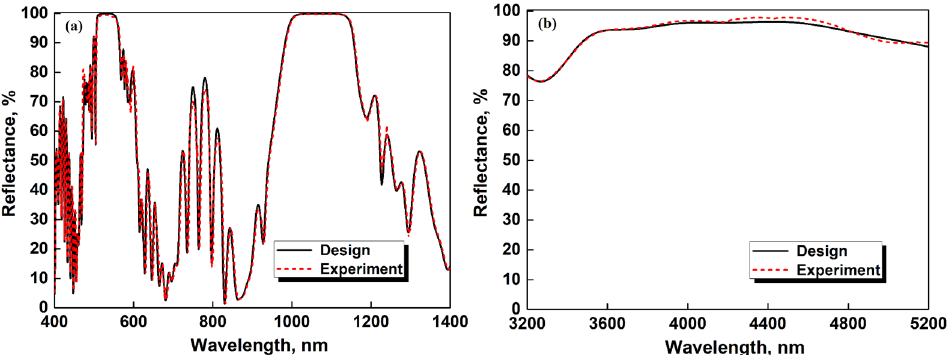
Figure 8. Comparison of measured spectrum data and theoretical spectrum in the range 400–1400 nm ( a ) and 3200–5200 nm ( b ) for the silicon substrate with both coated sides.